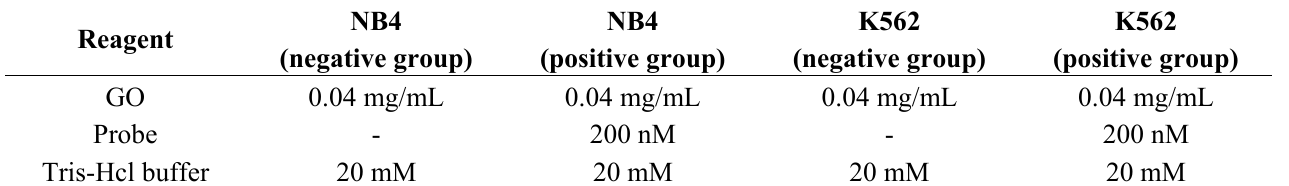
Table 1. The Formulations of the incubated liquid with Cells.